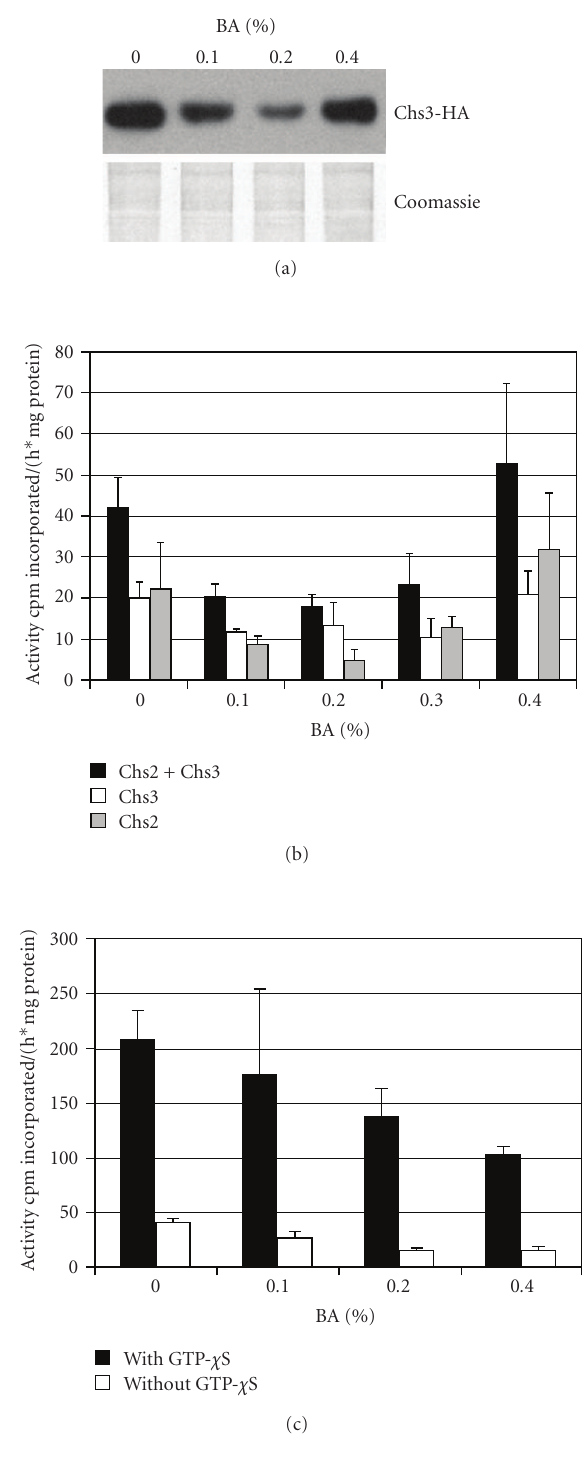
Figure 7: Glucan and chitin synthase activities in BA-treated cells. (a) Abundance of HA-tagged Chs3p in strain YMS415 treated with BA. Note the increase of Chs3p-HA at 0.4% BA. (b) Chitin synthase 2 and 3 activities in strain ECY46-1-8D. After a decline at lower BA concentrations, chitin synthase activities increase at 0.4% (c) Glucan synthase activities. Solid bars indicate activity after activation by GTP- χ S. Both maximal and physiological glucan synthase activities decline with increasing BA